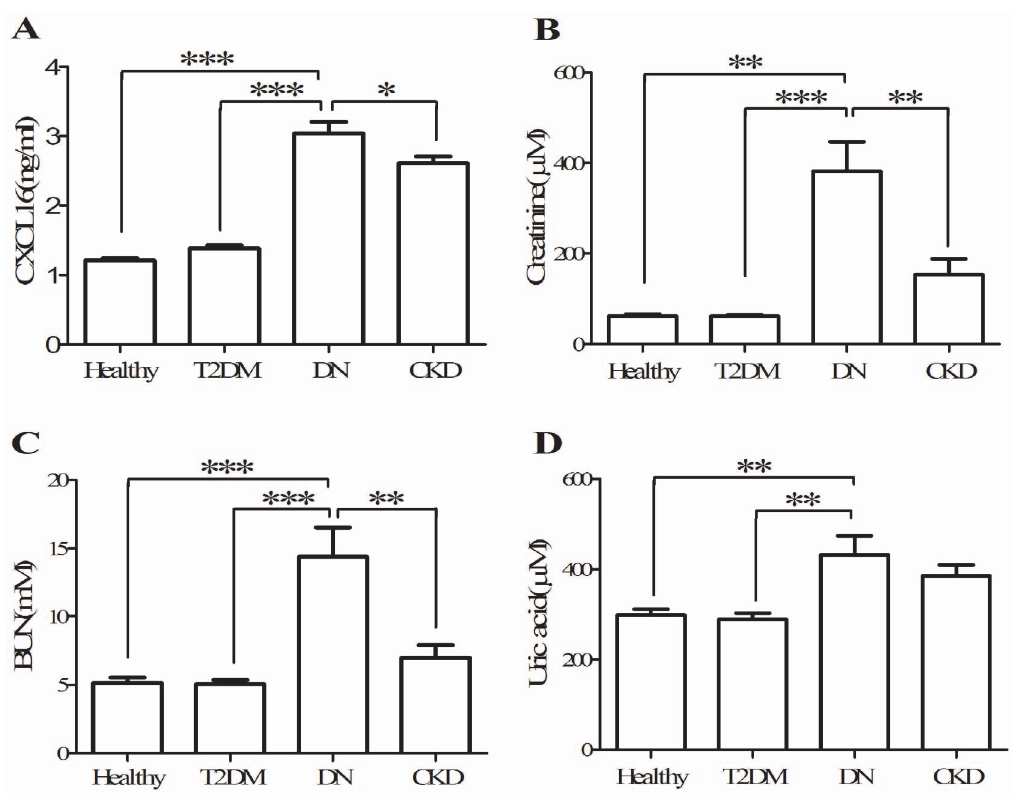
Figure 2. Serum concentration of CXCL16 (A), creatinine (B), BUN (C), and uric acid (D) among T2DM, DN, CKD, and healthy subjects. *, p , 0.05; **, p , 0.01; ***, p , 0.001.